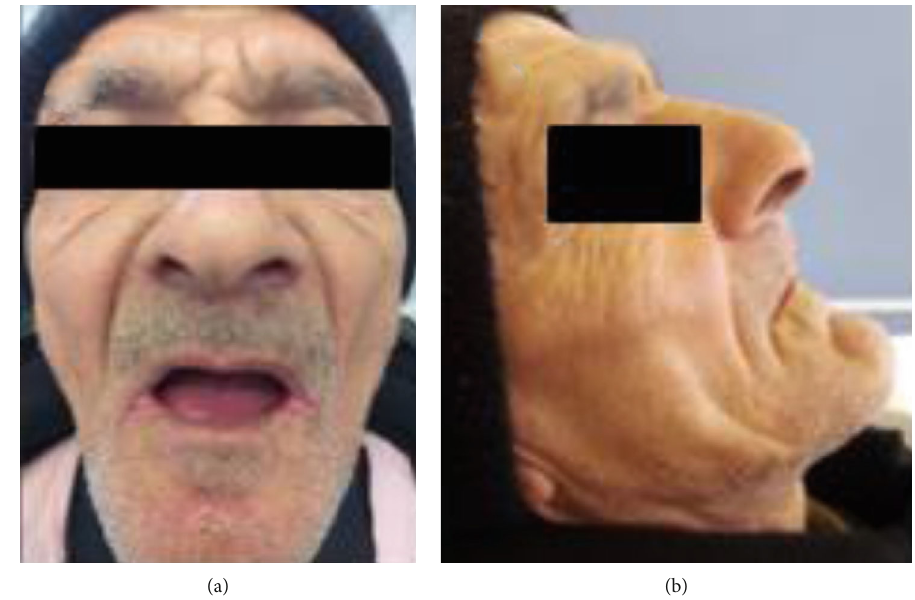
Figure 10: Extraoral examination: (a) front view and (b) side view.